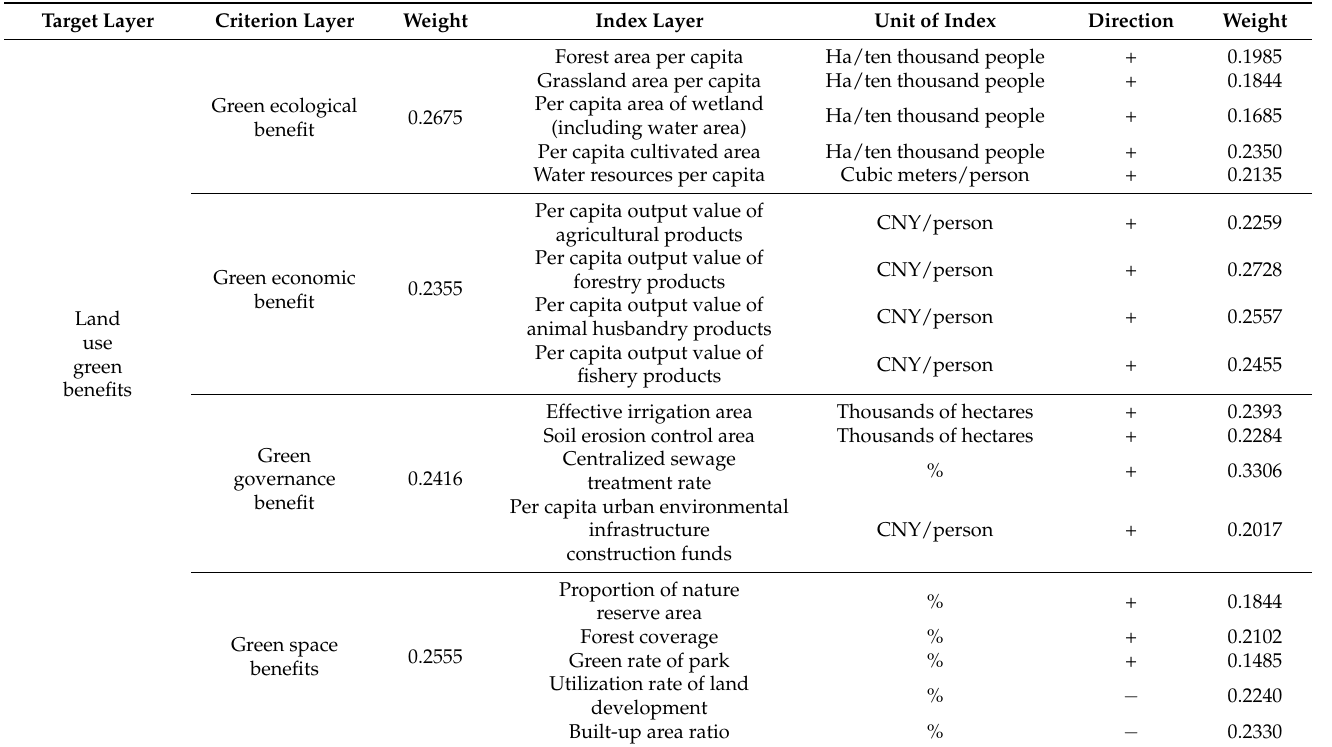
Table 1. Green land use benefit index system and BP network index weight in Beijing–Tianjin–Hebei